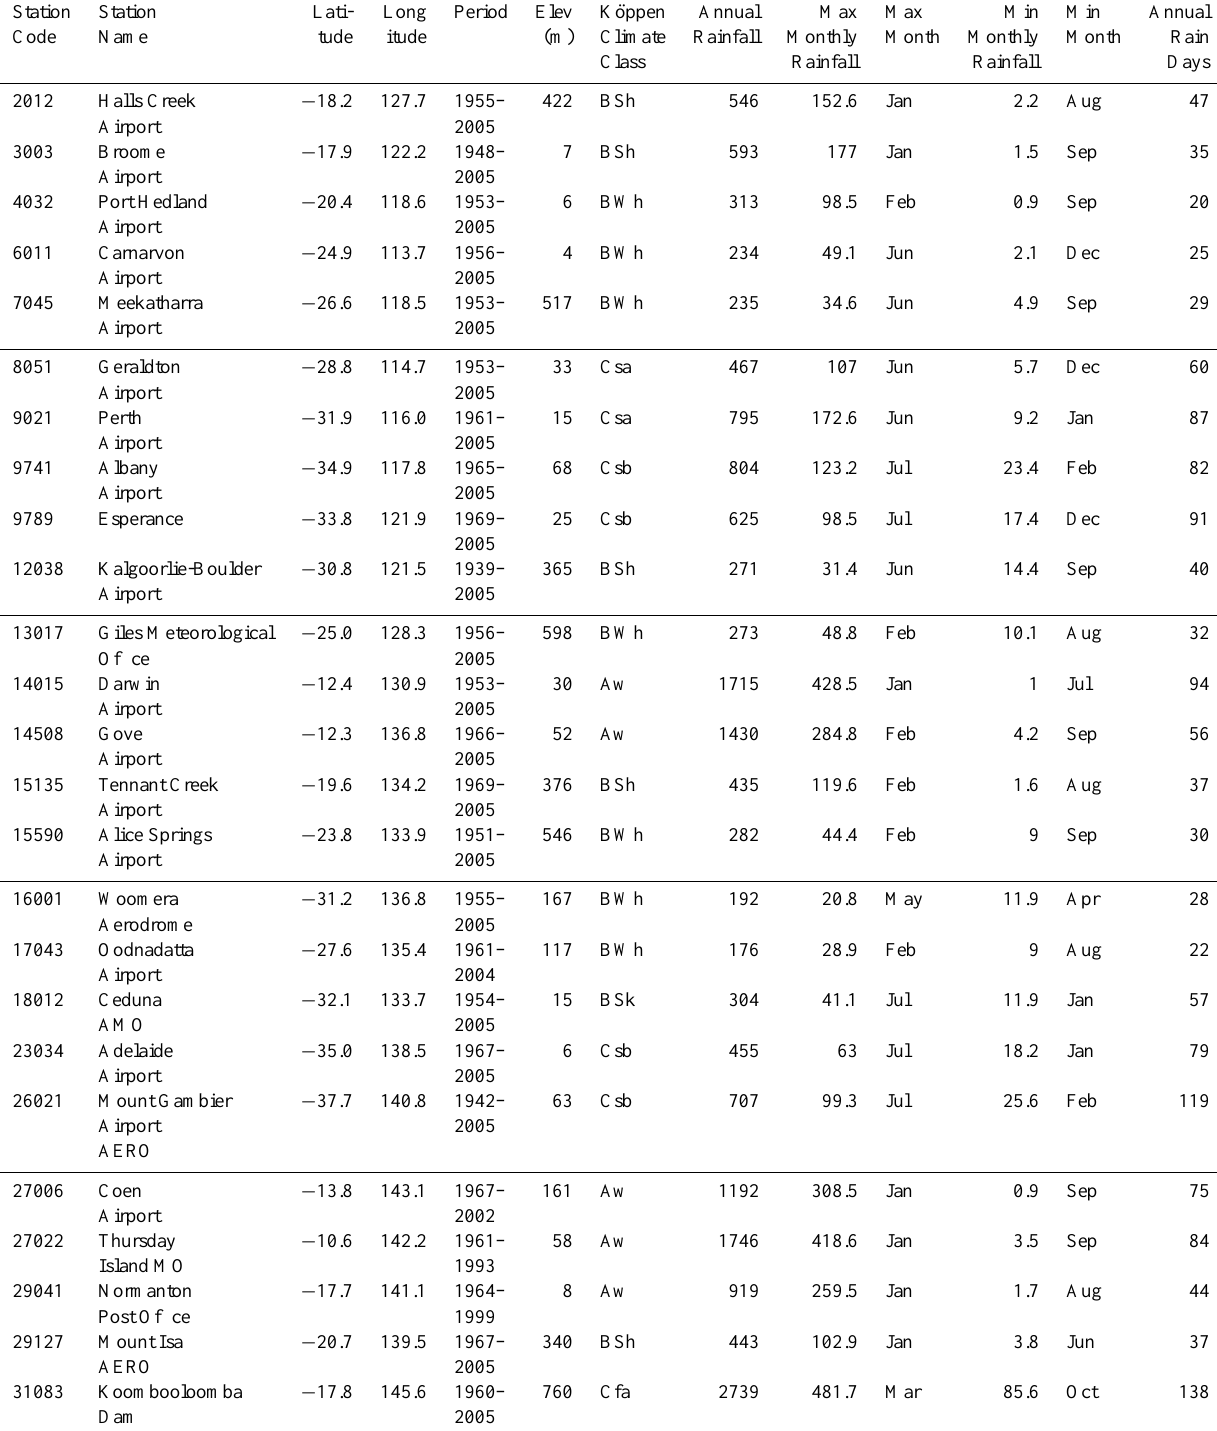
Table 1. Properties of the 42 study